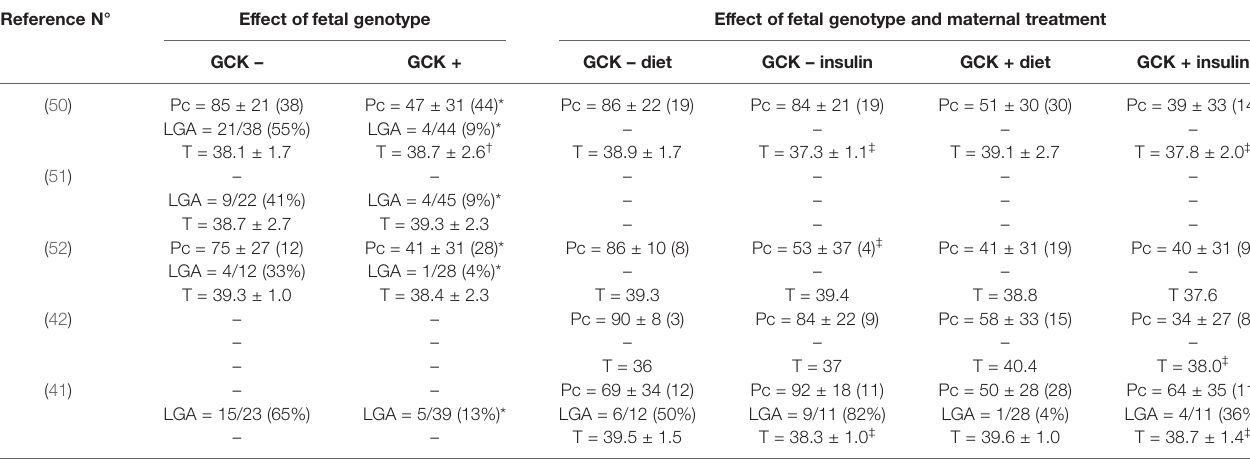
TABLE 1 | Birthweight percentiles, frequency of large for gestational age newborns and gestational age at delivery according to fetal genotype and treatment of diabetes in GCK-MODY mothers. Reference